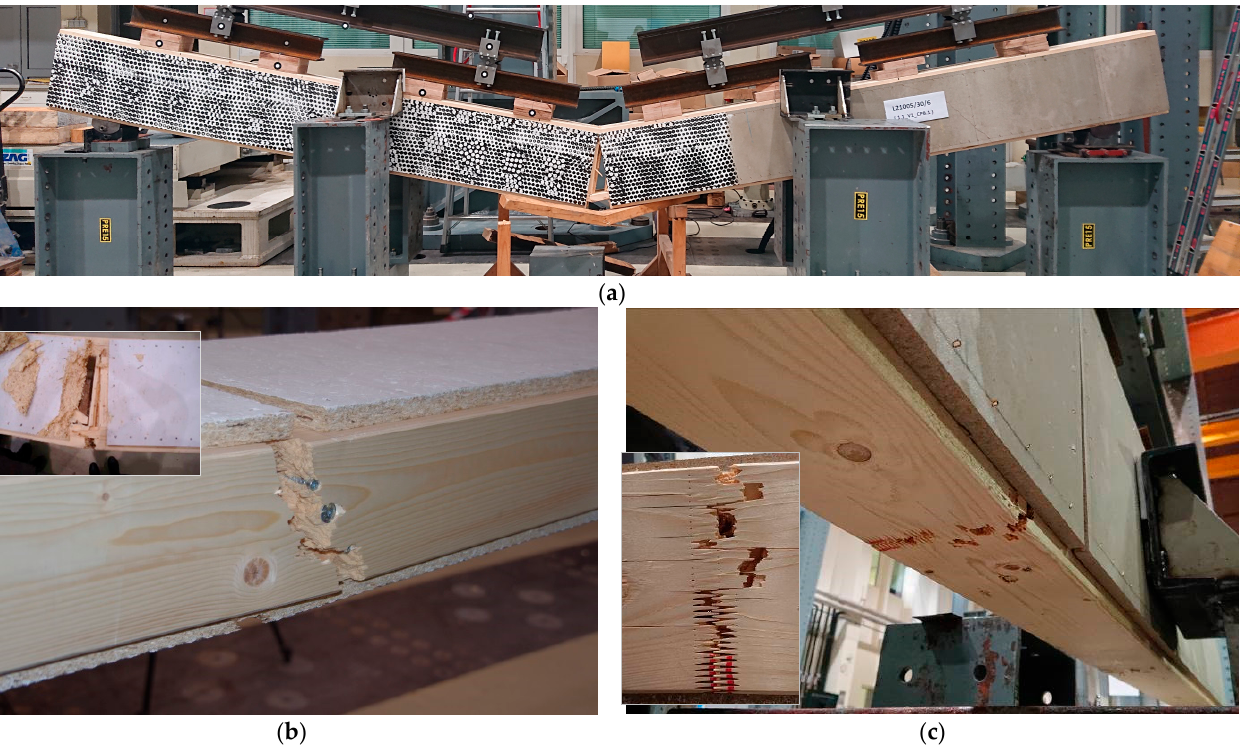
Figure 7. Typical failure mechanism of beams with cement-particle boards with failure of the bottom flange: ( a ) Failure of the beam with obtained damage of the boards; ( b ) Failure of the bottom flange at stiffener–flange joint with stiffener splitting (smaller photo in the corner); ( c ) Failure of the bottom flange at finger joint of the lower lamella (specimen 1.3-V2D-CPB.2*) with approximately 30% of the finger joint failing in glue-line (smaller photo in the corner).